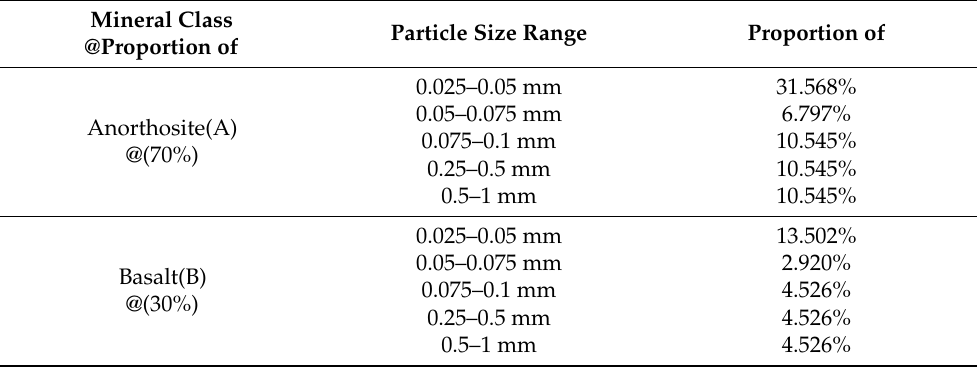
Table 2. The minerals, particle size range, and content of simulated lunar soil samples.